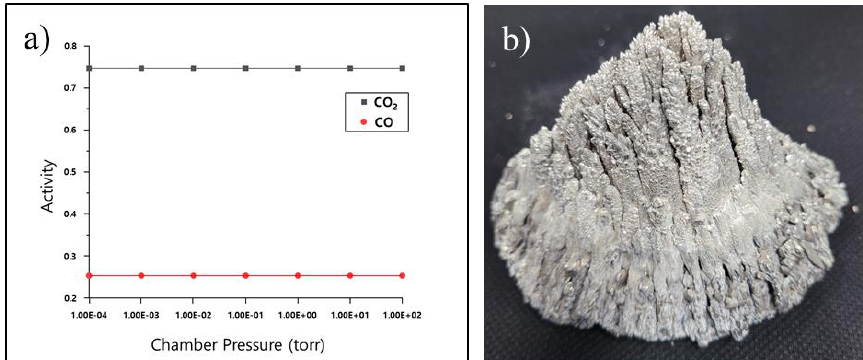
Figure 10. Activities of CO 2 and CO according to the pressure changes in the chamber at 600 °C ( a ) and Mg crown ( b ).